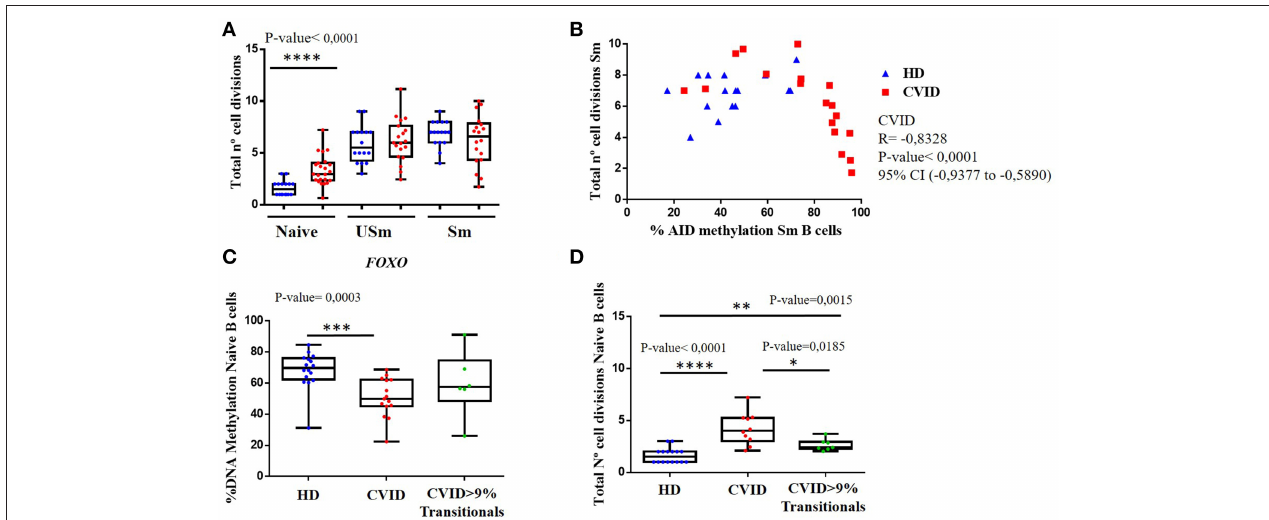
FIGURE 3 | (A) Total number of cell divisions calculated by KREC assay, for the different B cell populations, naïve, unswitched (USm) and switched (Sm) memory B cells in HD (blue) and CVID patients (red). (B) Correlation between numbers of cell divisions in switched memory (Sm) B cells and the corresponding percentage of methylation of the selected CpG in AICDA in healthy donors (blue) and CVID patients (red). Spearman correlation test was used in CVID patients Spearman coeficient = − 0.8328, p < 0.0001, 95% confidence interval ( − 0.9377 to − 0.5890) in HD Spearman coeficient = 0.3130, p = 0.2367, 95% confidence interval ( − 0.2317 to 0.7082). (C) Box and whiskers showing the percentage of DNA methylation in naïve B cells obtained by pyrosequencing for the selected CpG in FOXO in HD (blue), CVID without expansion of transitional B cells (red) and patients with > 9% transitional B cells (green). (D) Total number of cell divisions calculated by KREC assay in naïve B cells in HD (blue), CVID without expansion of transitional B cells (red) and patients with > 9% transitional B cells (green). P -value of statistically significant differences by Mann-Whitney test are included (* p < 0.05; ** p < 0.01; *** p < 0.001; **** p < 0.0001).